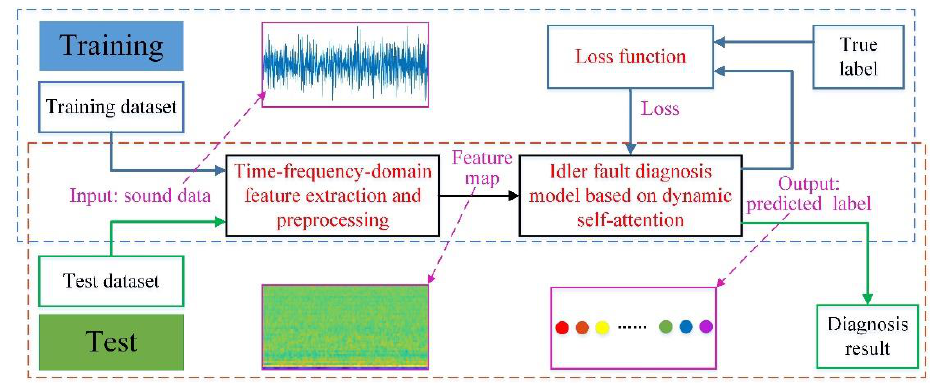
Figure 2. The dynamic self-attention-based idler fault diagnosis method.